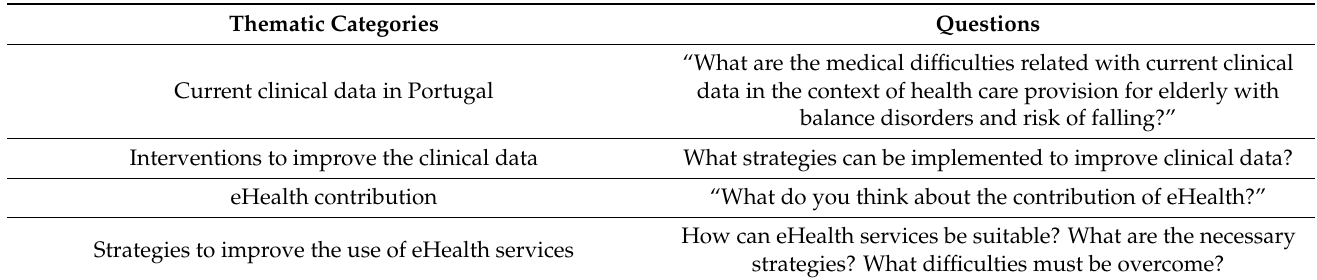
Table A2. Qualitative study: Interview